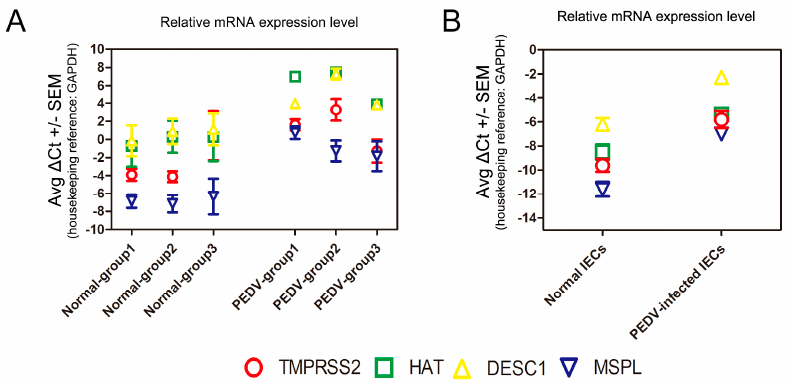
Figure 6. Expression of TTSPs in the normal and PEDV-infected porcine small intestine/intestinal epithelial cells (IECs). ( A ) Expression of TTSPs in the normal and PEDV-infected porcine small intestine; ( B ) Expression of TTSPs in the normal and PEDV-infected IECs.